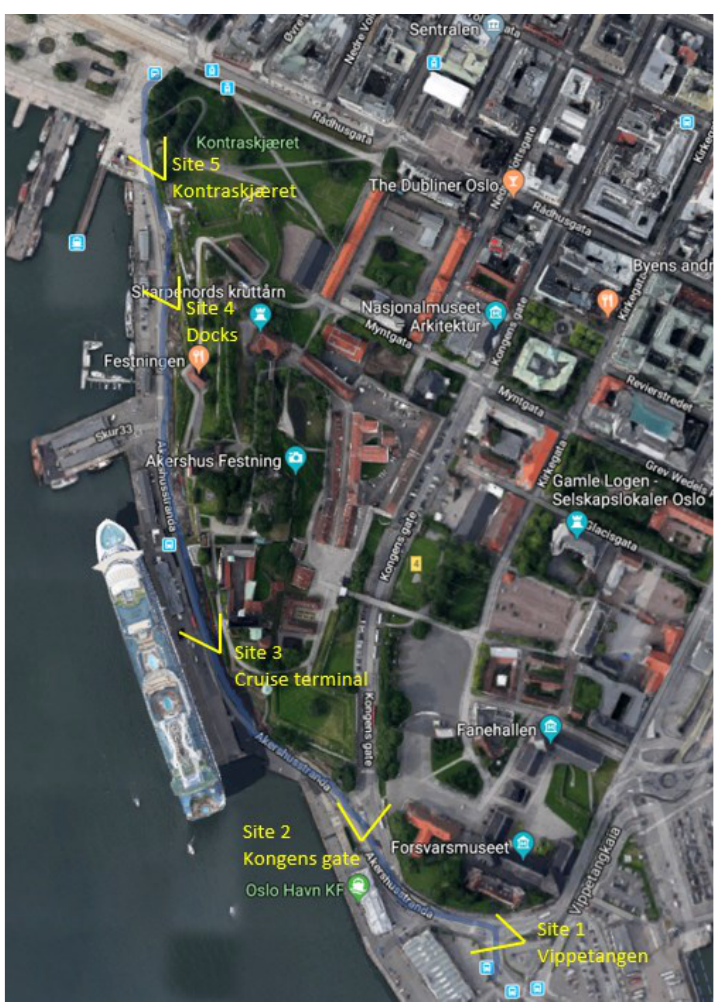
Figure 1 Shuttle route with video recording sites indicated. Source : GoogleMaps image with own